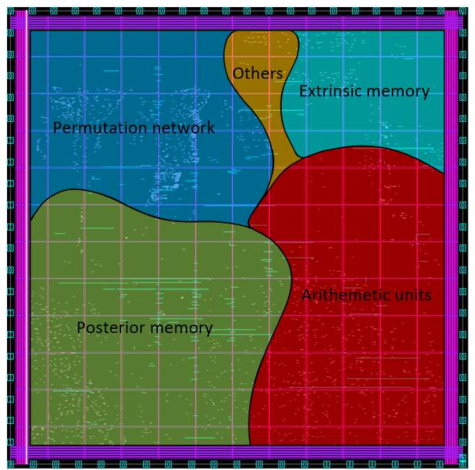
Figure 9. Chip layout of the proposed dual-mode LDPC